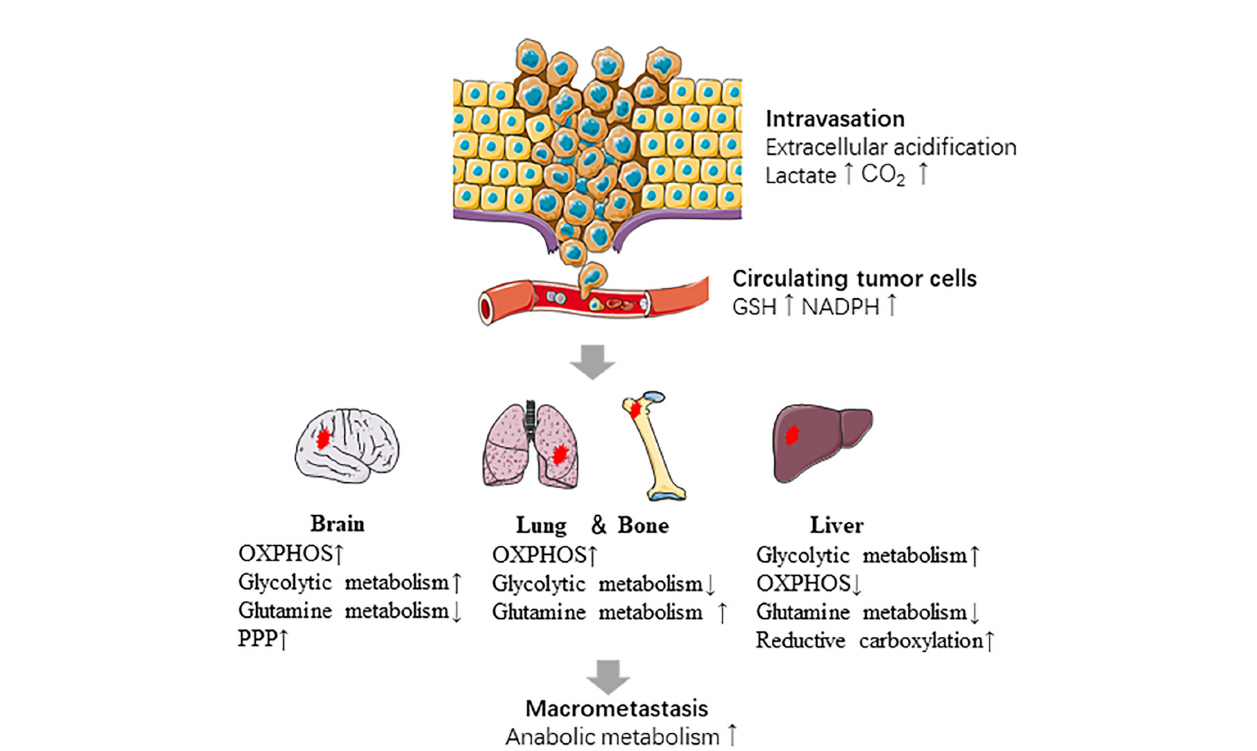
FIGURE 2 | Metabolic reprogramming in the metastatic cascade. Metabolic reprogramming occurs at several steps of metastasis. The intravasation of cells from the primary tumor is promoted by extracellular acidi fi cation. CTCs survive in oxidative stress by producing NADPH and GSH. Cancer cells show different metabolic characteristics based on the sites which they metastasize. Last, anabolic metabolism is reactivated during macro-metastatic tumor